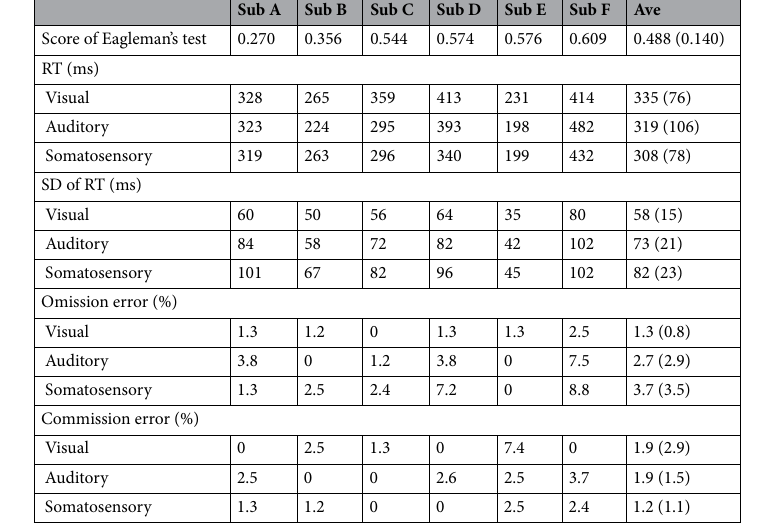
Table 1. Behavioral data during visual, auditory, and somatosensory Go/No-go paradigms in each synesthete.